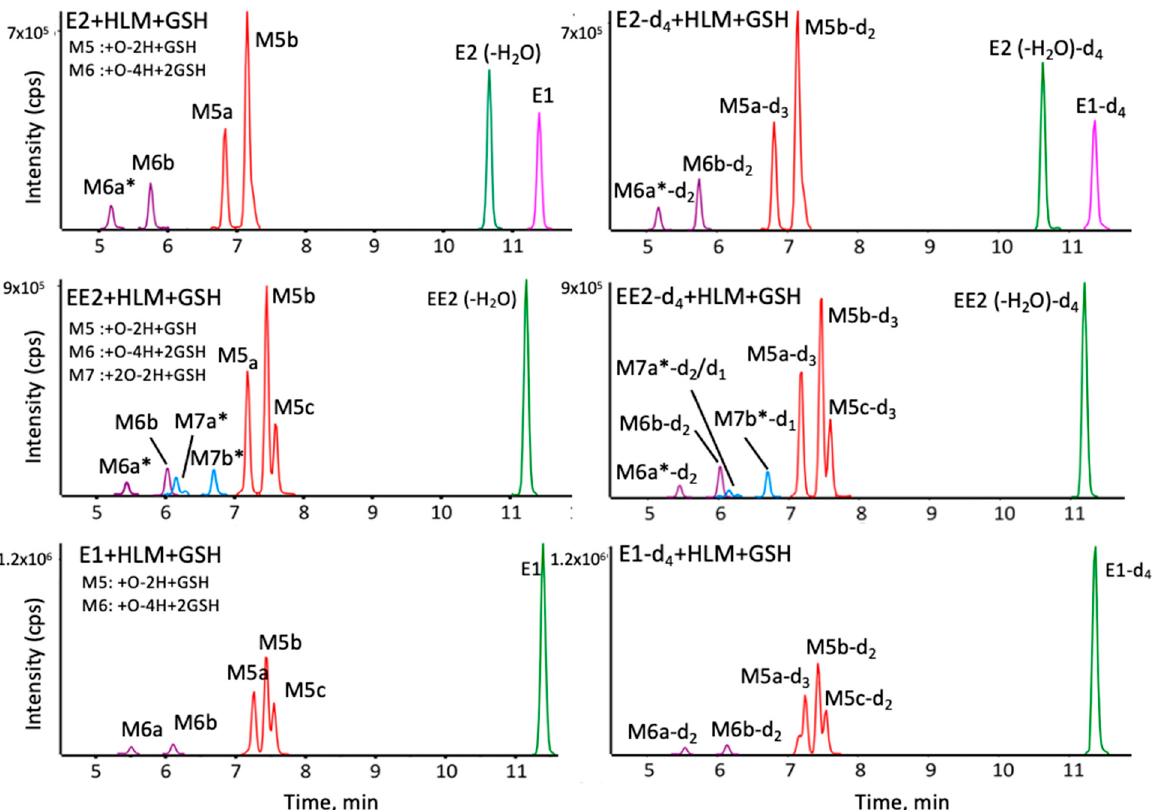
Figure 6. Extracted ion chromatograms of E2, EE2 and E1 metabolites and adducts trapped by GSH, for their non-labeled (left) and deuterated versions (right). Some peaks (*) were increased 5× for clarity. Details of measured m/z and molecular formulae can be found in Table 1.